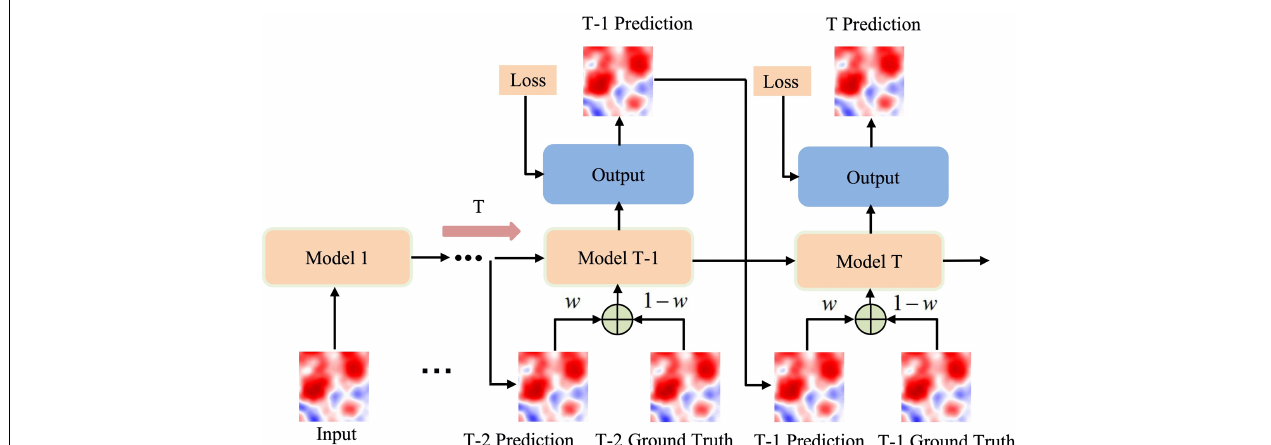
FIGURE 4 | Framework of the improved Scheduled